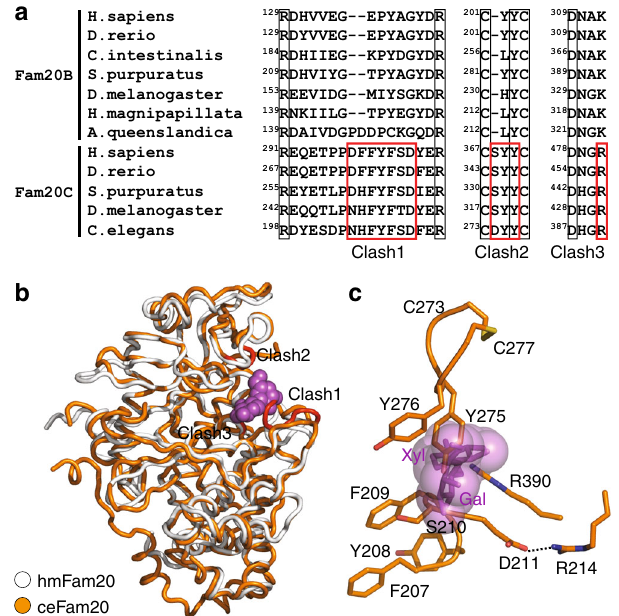
Fig. 7 Changes in Fam20C lead to the loss of glycan kinase activity. a Sequence alignment of Fam20B and Fam20C family members in three regions that are critical for substrate selectivity. Residues that are incompatible with disaccharide binding in Fam20C are highlighted using red boxes and labeled Clash1, Clash2, and Clash3. b ceFam20 (orange) is superimposed onto hmFam20 (white) in the Gal-Xyl bound structure. Gal- Xyl is shown as magenta spheres. The three clash regions in ceFam20 are highlighted in red. c A close view of the clash regions. Gal-Xyl is shown as magenta sticks enclosed in its van der Waals surface. F209, S210, Y275, and R390 in ceFam20 would clash with